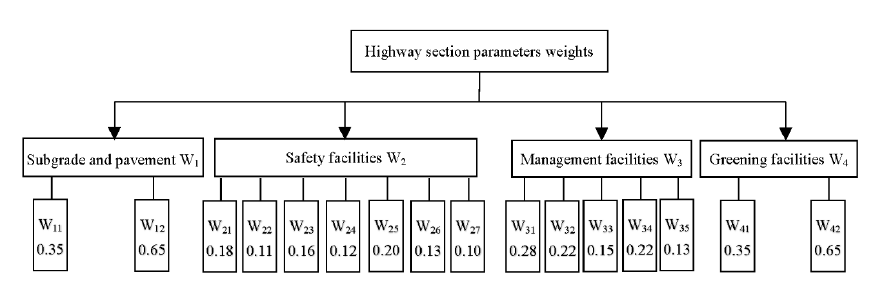
Fig. 2 Summary of highway section parameters weights.